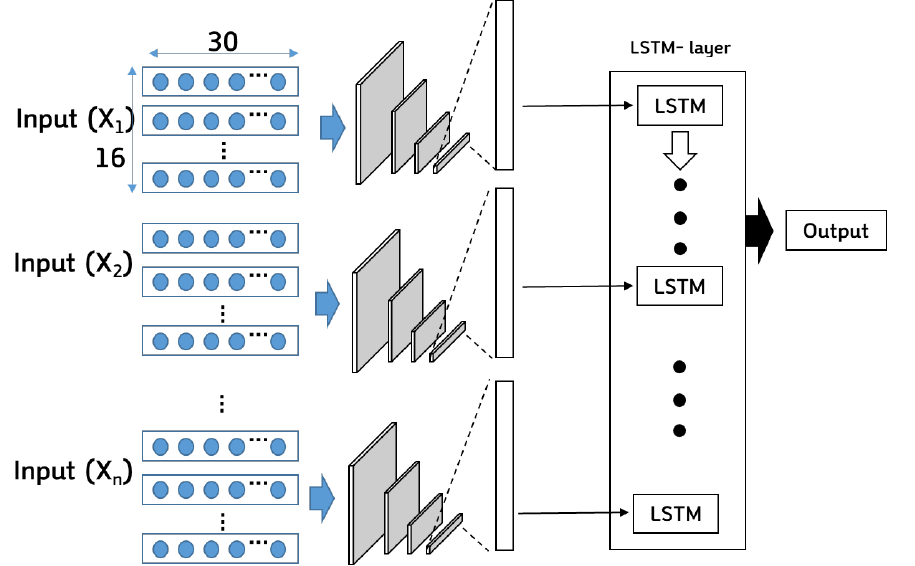
Figure 3. Overall conceptual diagram of the convolutional neural network–long short-term memory (CNN–LSTM)-based environmental prediction model.